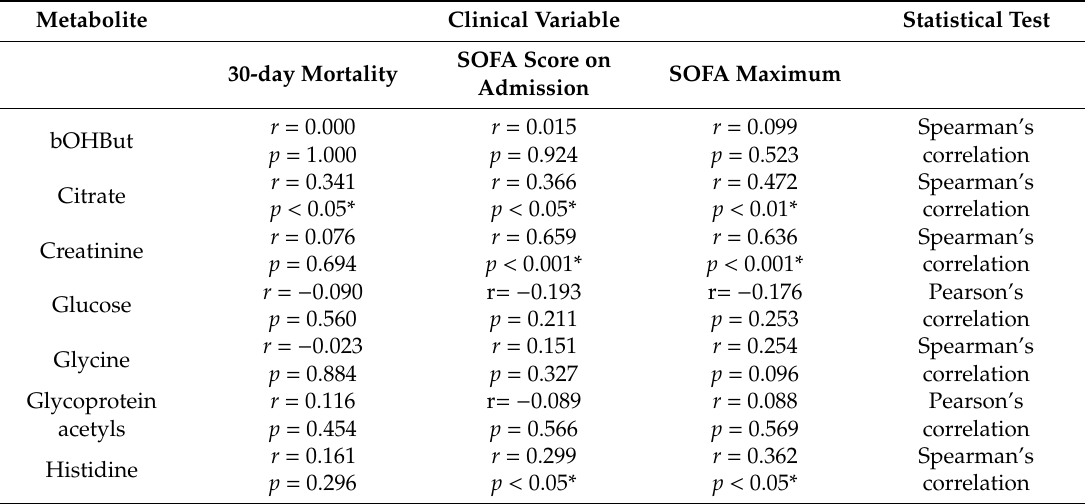
Table 4. Correlations between metabolites and clinical variables. The p values are considered significant when < 0.05 and marked with an *. SOFA = sequential organ failure assessment; bOHBut =